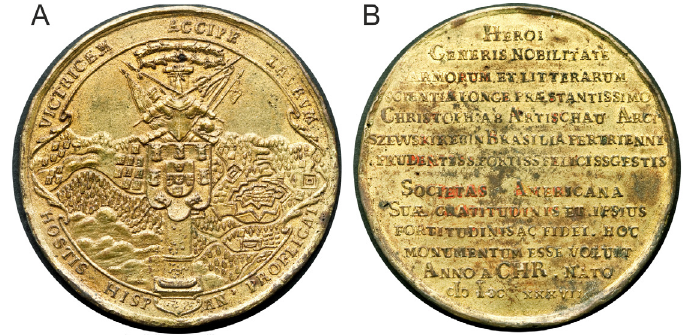
Fig. 4. A medal minted in honour of Krzysztof Arciszewski, 63 mm in diameter and weighing 55.1 g [the specimen auctioned in 2011 (J.W. Adams, D. Verschoor 2011, p.